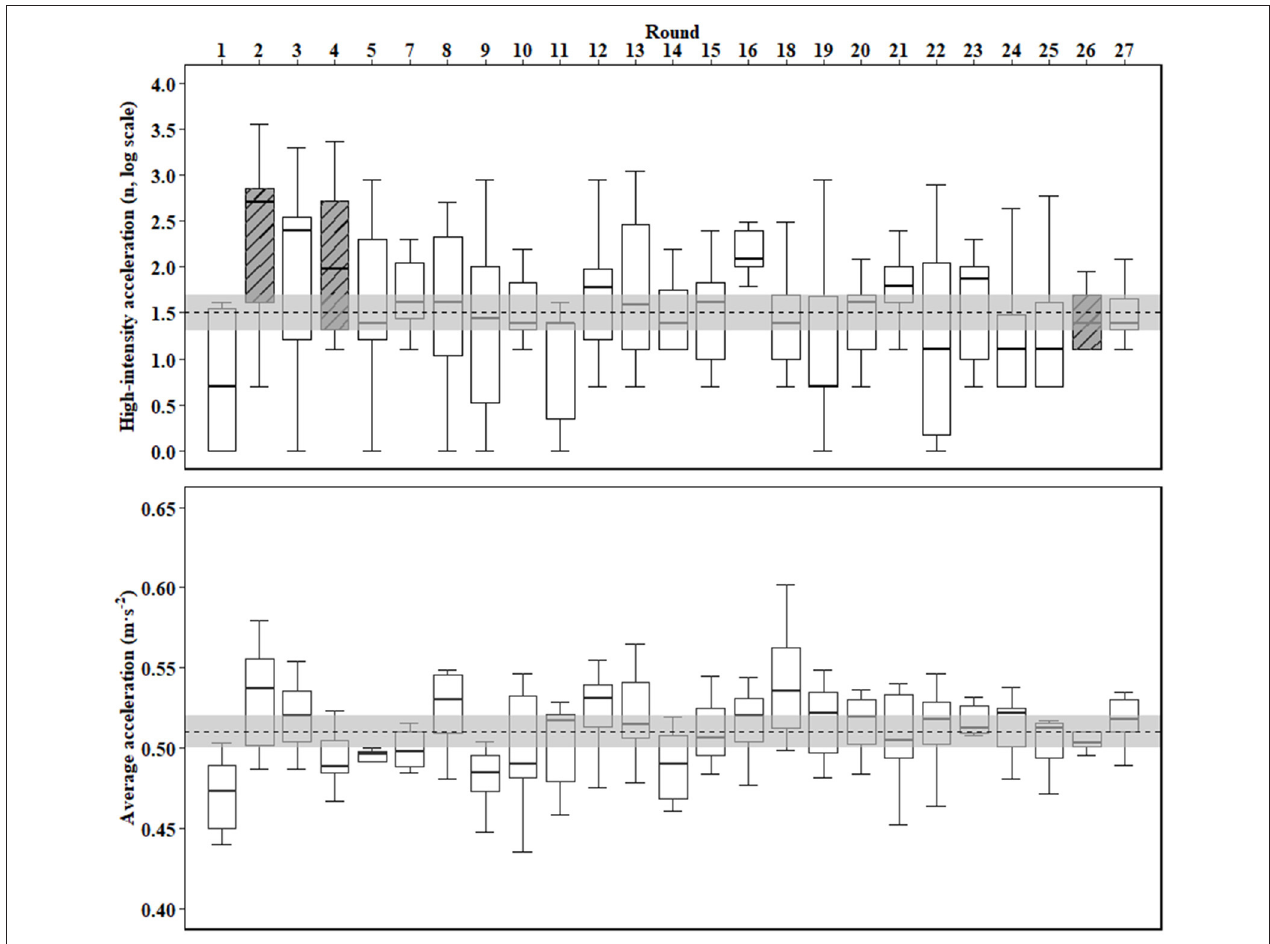
FIGURE 1 | The average number of high-intensity accelerations (top panel) and average acceleration (bottom panel) during a competitive season in elite youth football (rounds 6 and 17 were both bye rounds). Dotted line ( ) represents the team season mean; light gray band ( ) represents the smallest worthwhile change; and, patterned, dark gray boxplots ( ) represent rounds in which at least one RHAA bout occurred from at least one